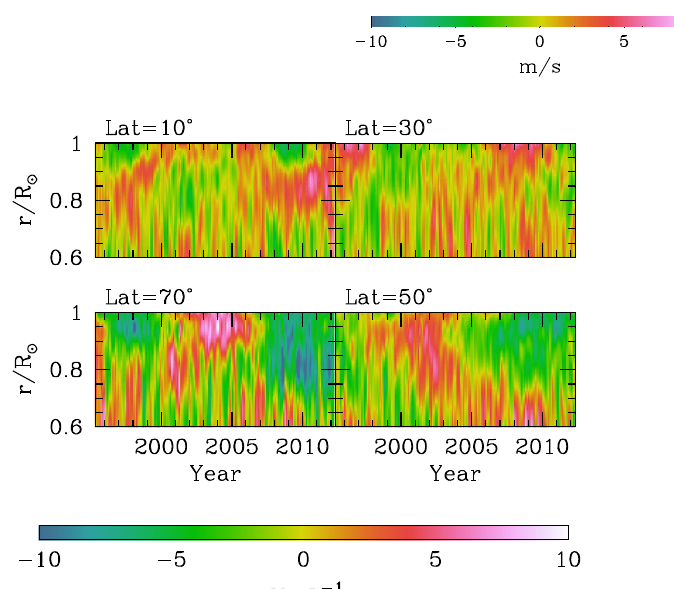
in the outer layers. The results for deeper layers are too noisy to draw any